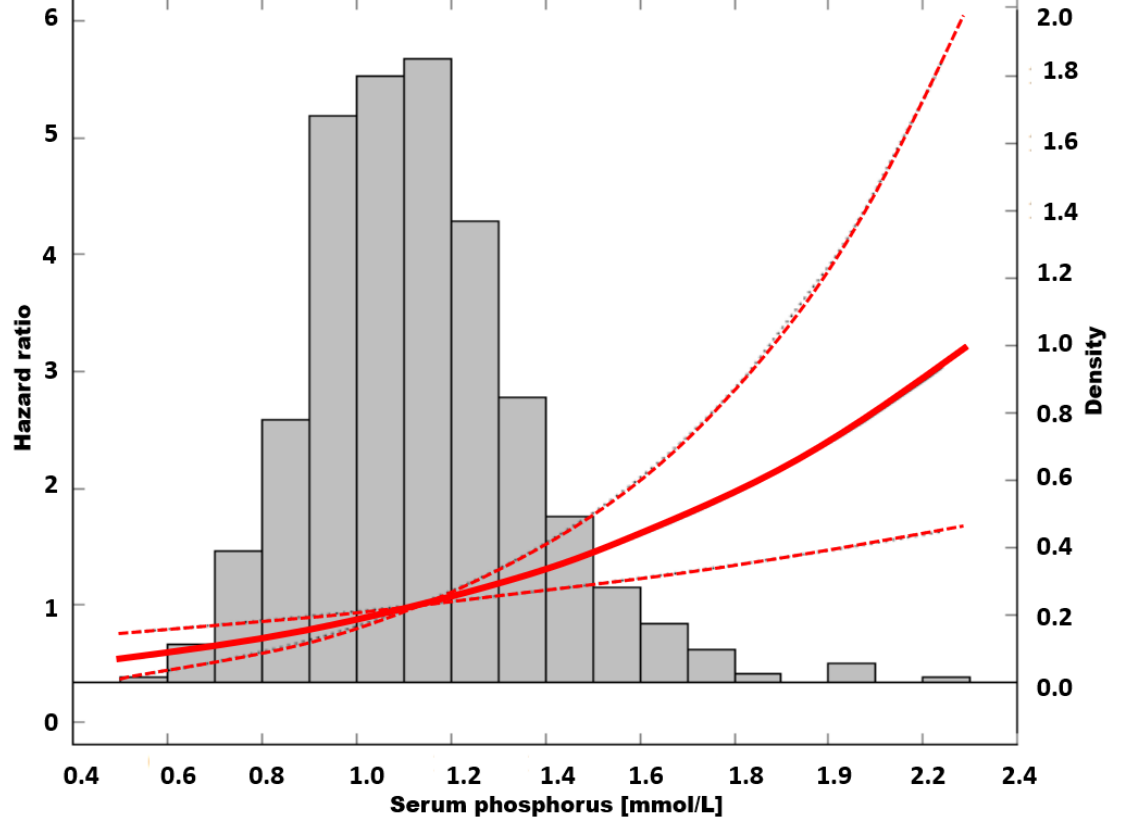
Figure 4. The risk of all-cause mortality in unadjusted model. By fitting serum calcium into the unadjusted model, we tried to disclose the possible interaction of serum calcium and phosphorus as risk factors for mortality. The adjustment has changed the risk marginally in the lowest sP; however, the risk of death was increasingly attenuated in each incremental quintile of sP. The greatest reduction in the hazard